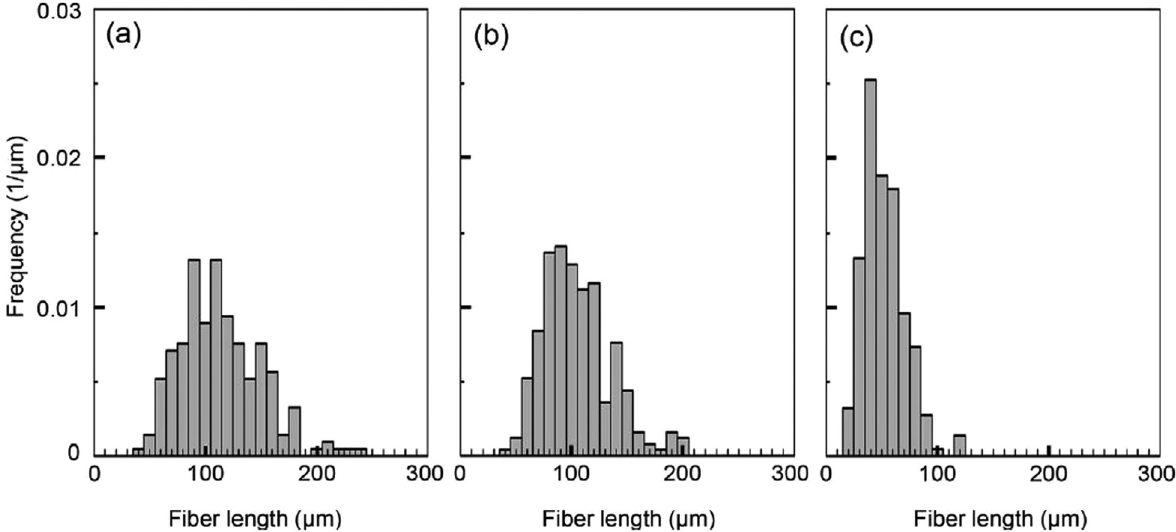
Figure 4: Fiber length distribution of ( a ) 0, ( b ) 4, and ( c ) 38 wt% TiO 2 nanoparticles - reinforced nano fi bers [ 107 ] ; Copyright 2014, reproduced with permission from Elsevier